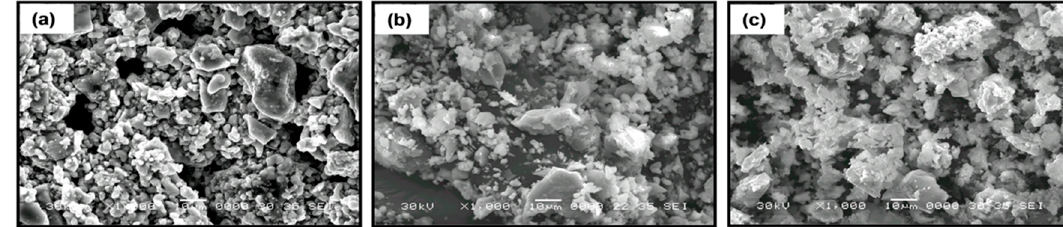
Figure 7. SEM micrographs of composite electrolytes formed by La 0.5 Li 0.5 TiO 3 and 10 wt.% of polymer ( a ) PEG, ( b ) PEO, and ( c ) PAN.